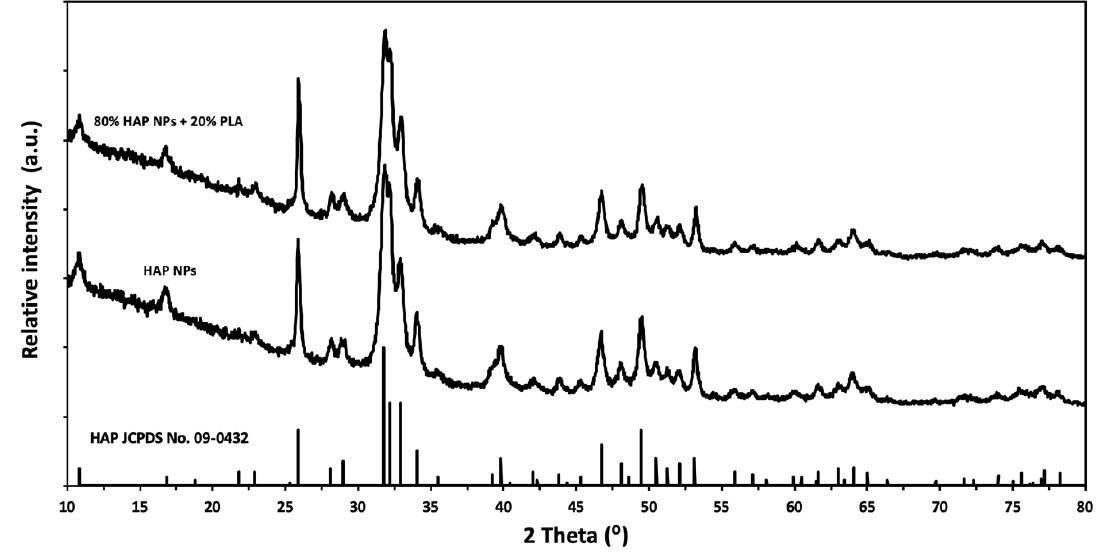
Figure 1. XRD of the HAP NPs and composite granules.